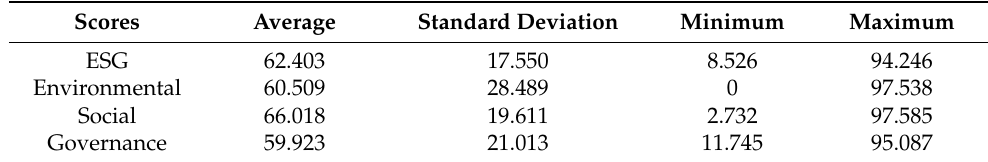
Table 3. Descriptive statistics of the ESG